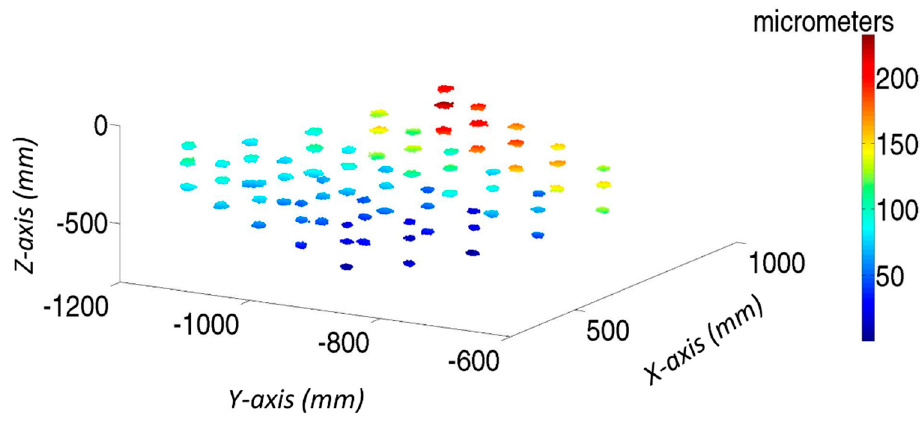
Figure 13. Initial color map of verification points of 1000 tests on laser tracker coordinate system.